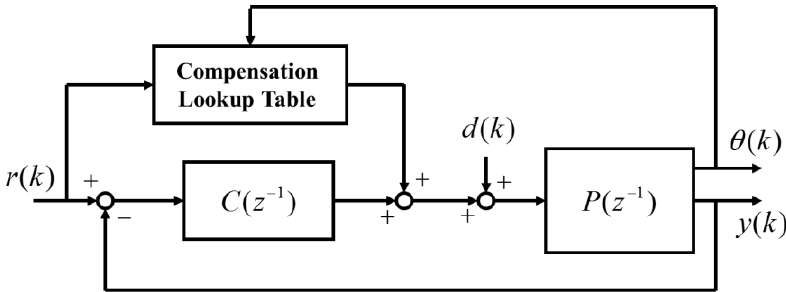
Figure 12. Conventional feedback controller with a compensation lookup table.